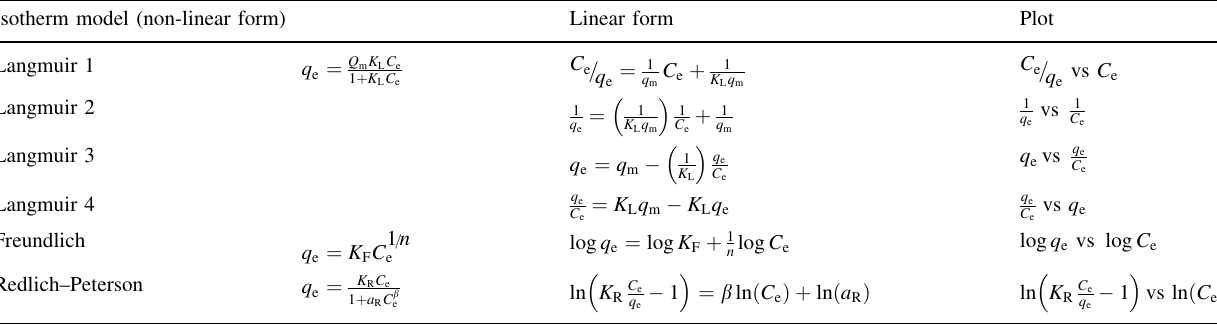
Table 1 Selected adsorption isotherms and their linear forms with corresponding plots Isotherm model (non-linear form) Linear form